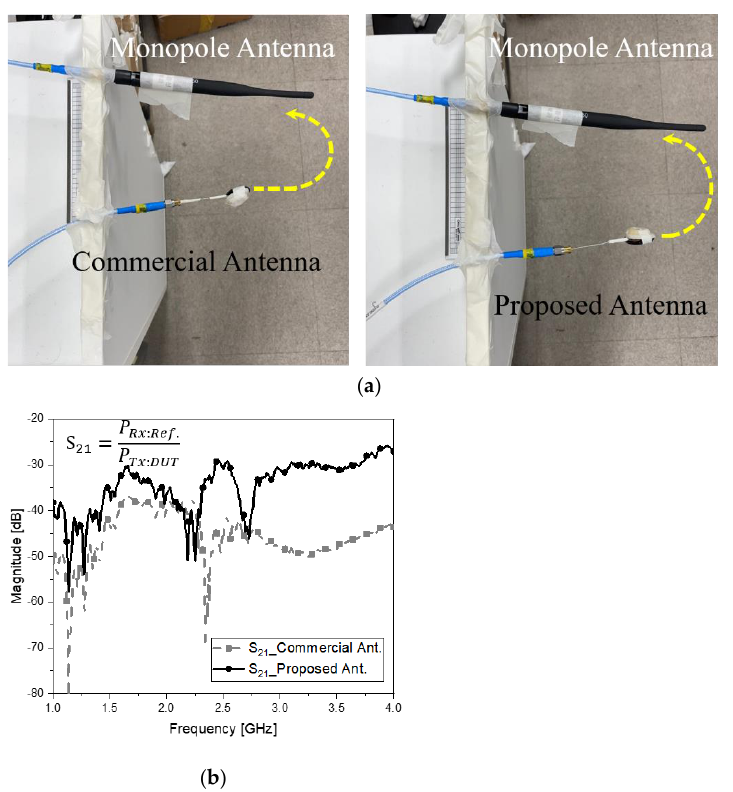
Figure 10. Basic characterization method of the antennas. ( a ) Wire antenna vs. the proposed antenna (left) and wire antenna vs. the commercial antenna (right); ( b ) transmission ratios from the two test cases.